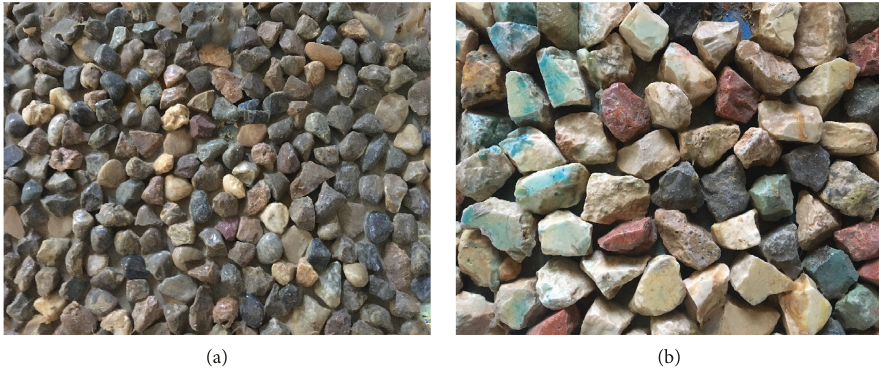
Figure 3: Graver bed arrangement for (a) k